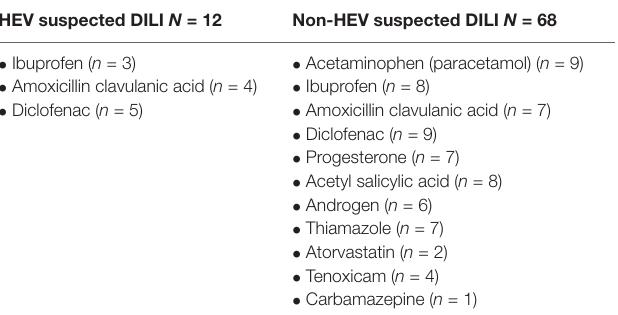
TABLE 2 | Drugs reported with HEV and non-HEV suspected DILI